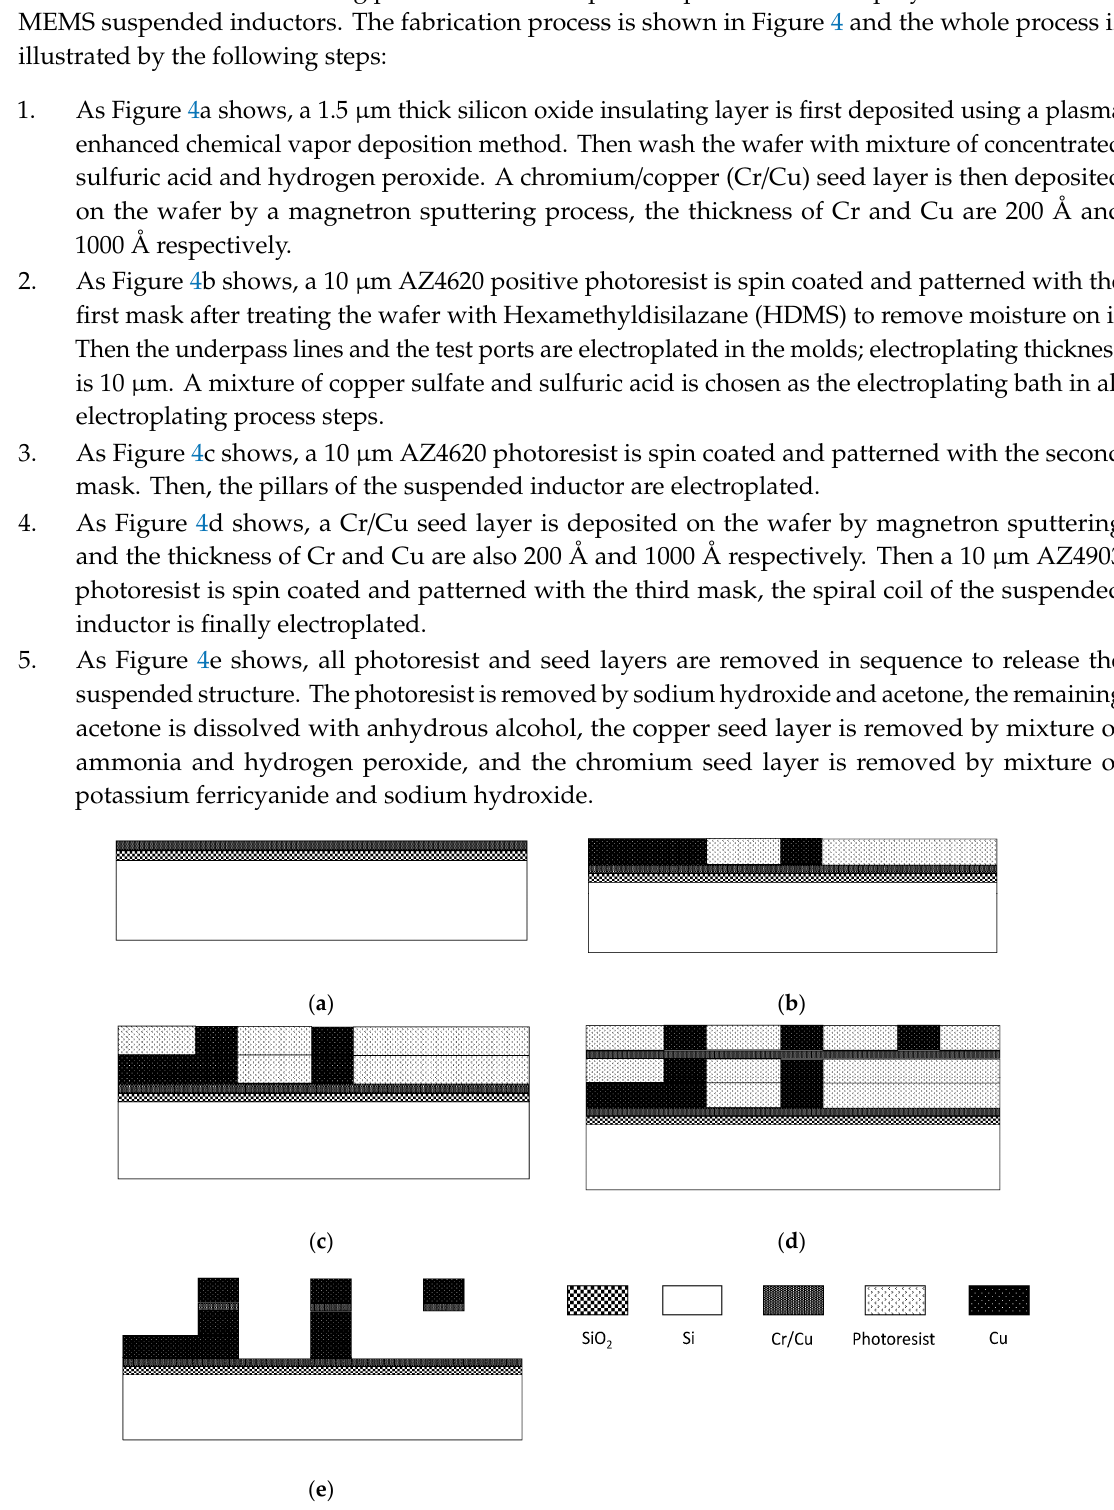
Figure 4. Fabrication process of the MEMS suspended inductor. ( a ) Seed layer deposition; ( b ) photoresist (PR) mold patterning and copper electroplating; ( c ) PR mold patterning and copper electroplating; ( d ) seed layer deposition, PR patterning and copper electroplating; ( e ) PR strip and seed layer etch.